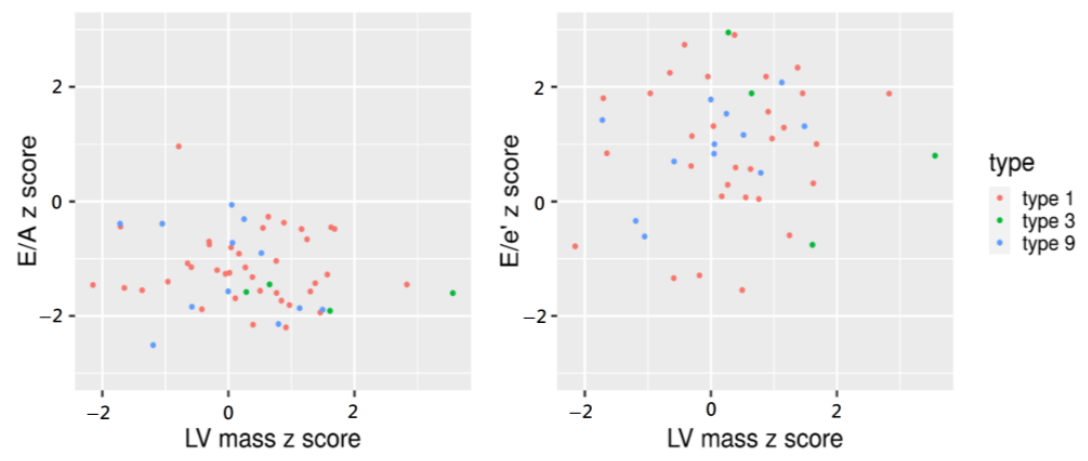
Figure 1. Tissue Doppler imaging for the evaluation of the left ventricle (LV) diastolic